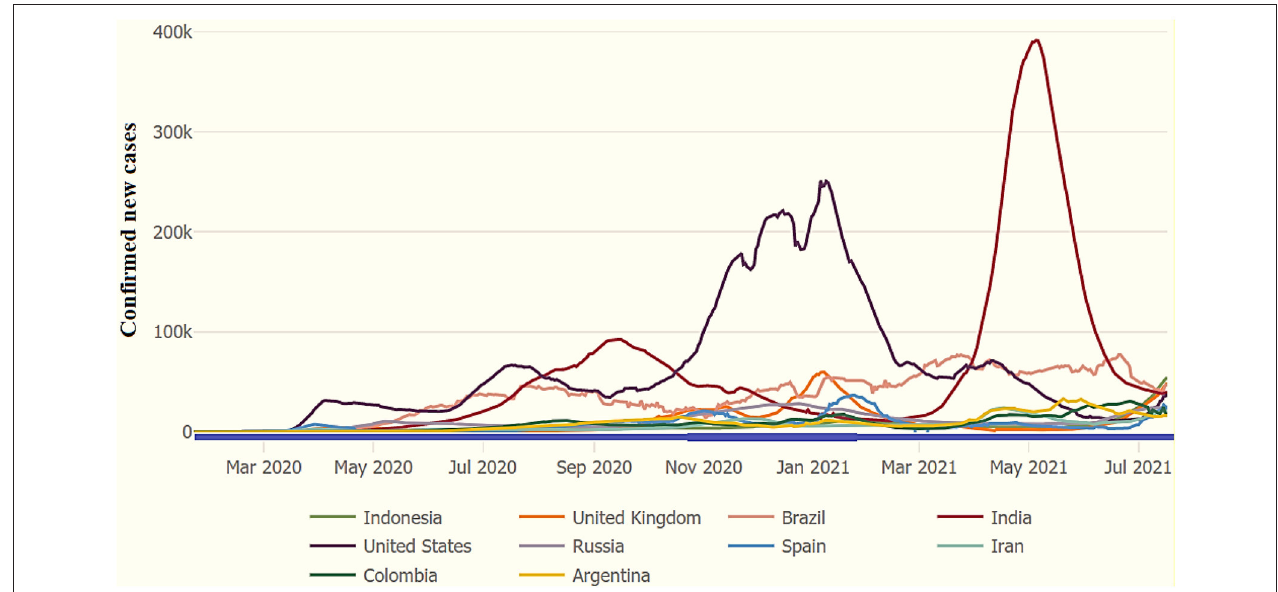
FIGURE 1 | COVID-19: Top 10 most affected countries (7-day moving average), as of July 18, 2021. Source: WHO and JHU COVID-19